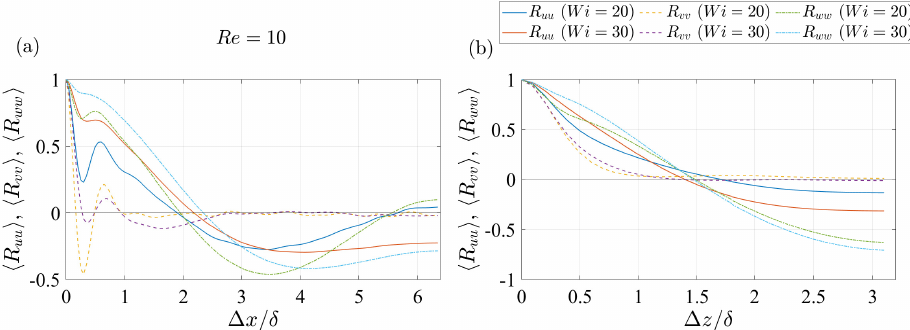
Figure 9. Two-point correlations as a function of ( a ) the streamwise distance ∆ x and ( b ) the streamwise distance ∆ z at the channel center for Re = 10 and varying Wi . The solid lines represent R uu , the dashed lines R vv , and the dash-dotted lines R ww